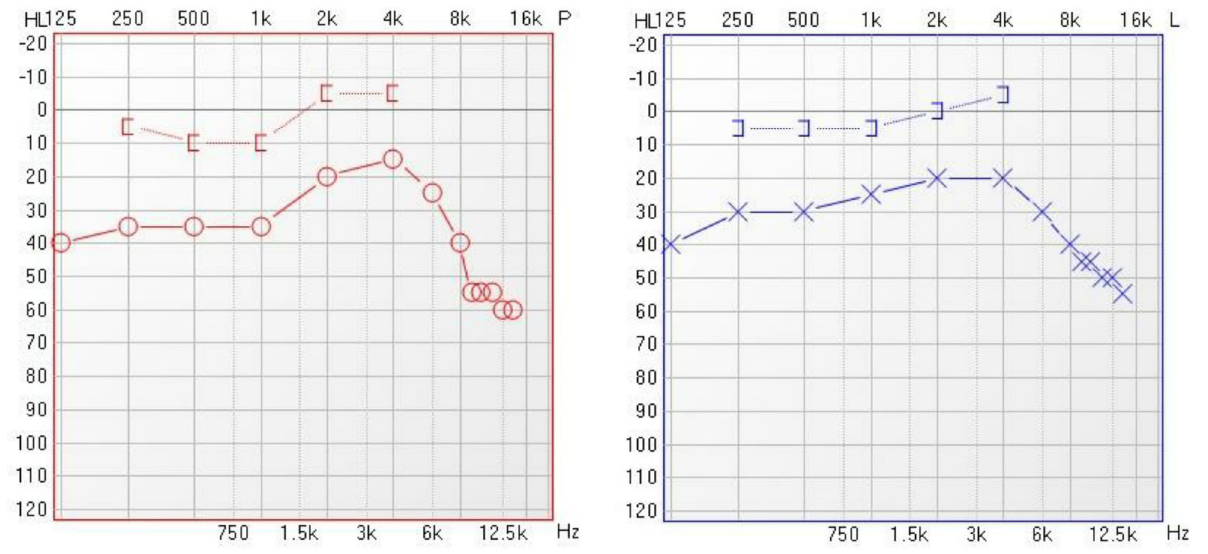
Figure 9. Results of pure tone audiometry, right and left